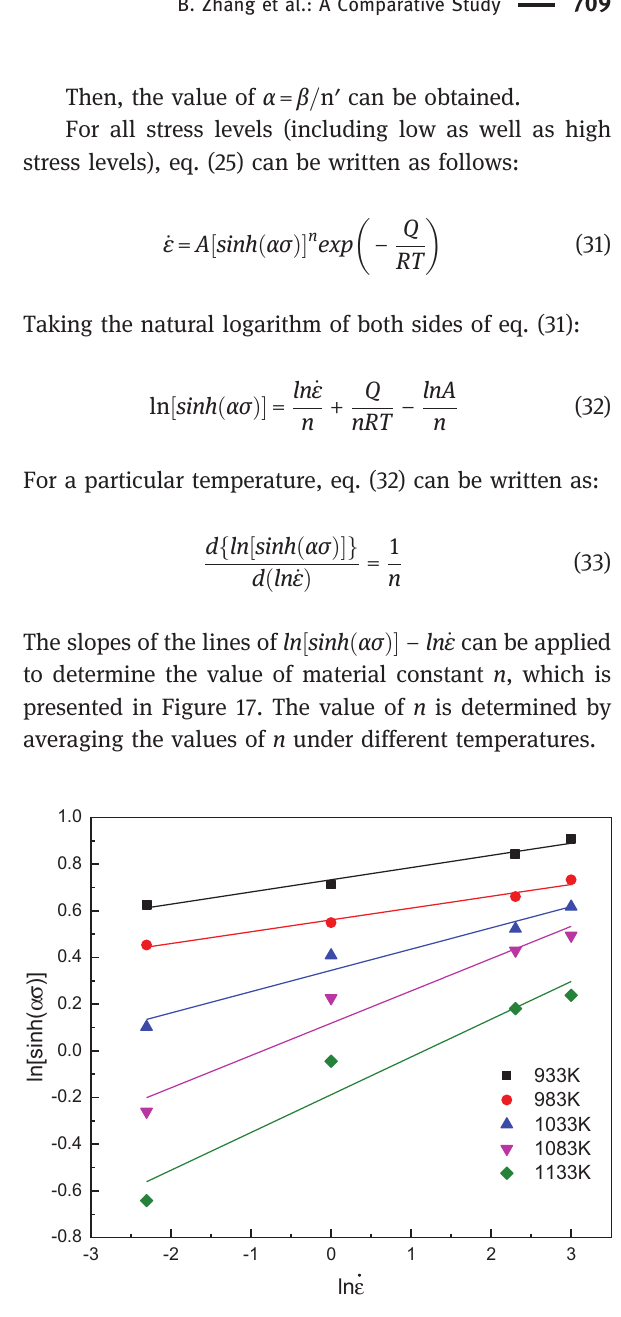
Figure 17: Relationship between ln sinh ασ ð Þ½ (cid:2) and ln _ ε